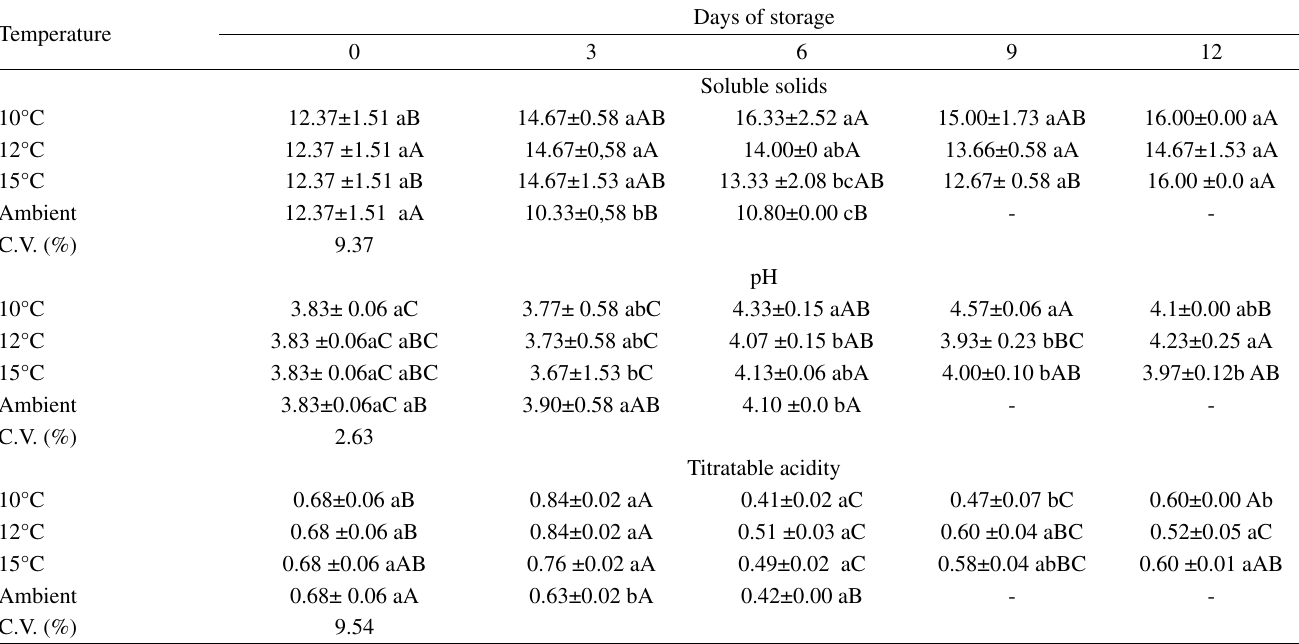
Table 3 - Soluble solids (°Brix), pH and titratable acidity (g of acid 100g -1 fresh weight) in buriti fruits under refrigerated storage (80±5%